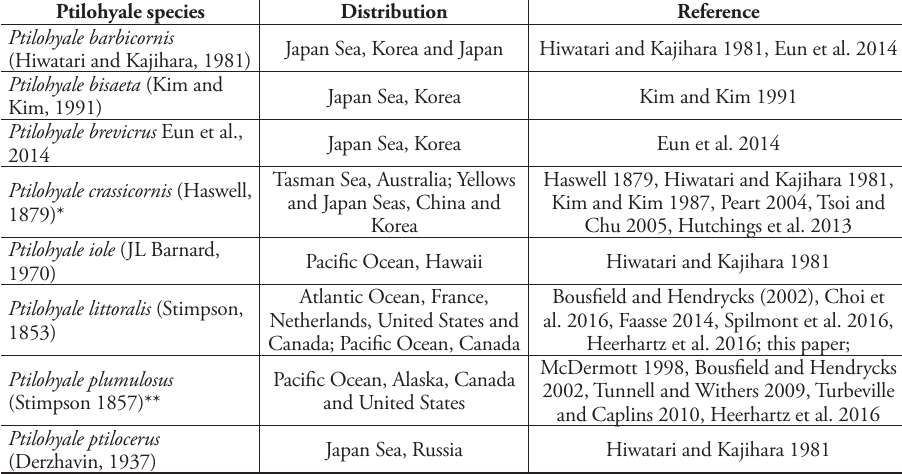
Table 4. List of Ptilohyale species exhibiting diagnostic generic characters, and their distribution.